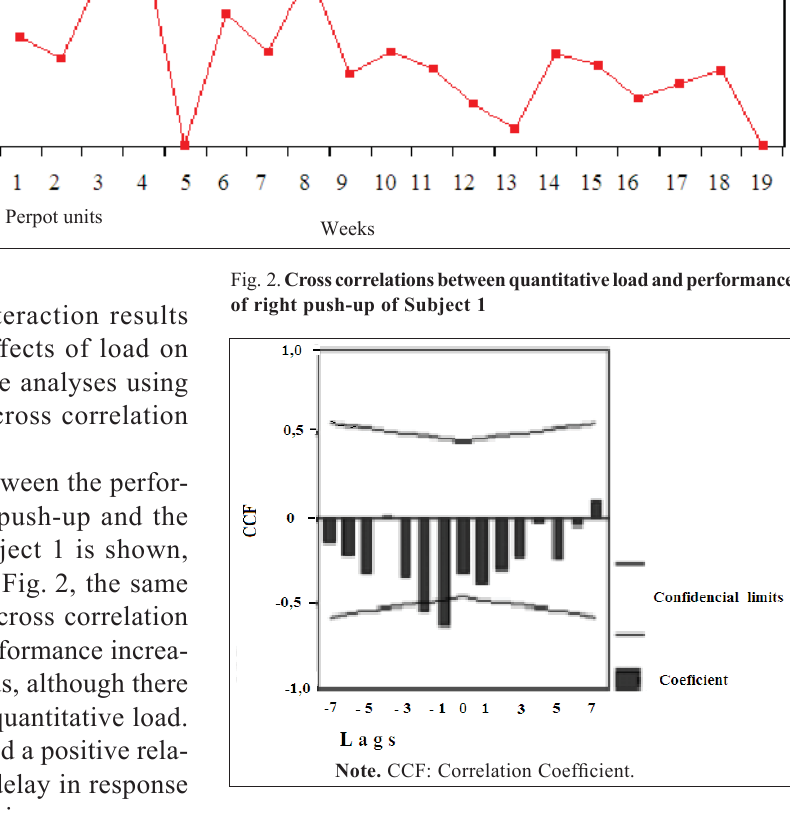
4. Cross correlations between qualitative load and performance of right push-up of Subject